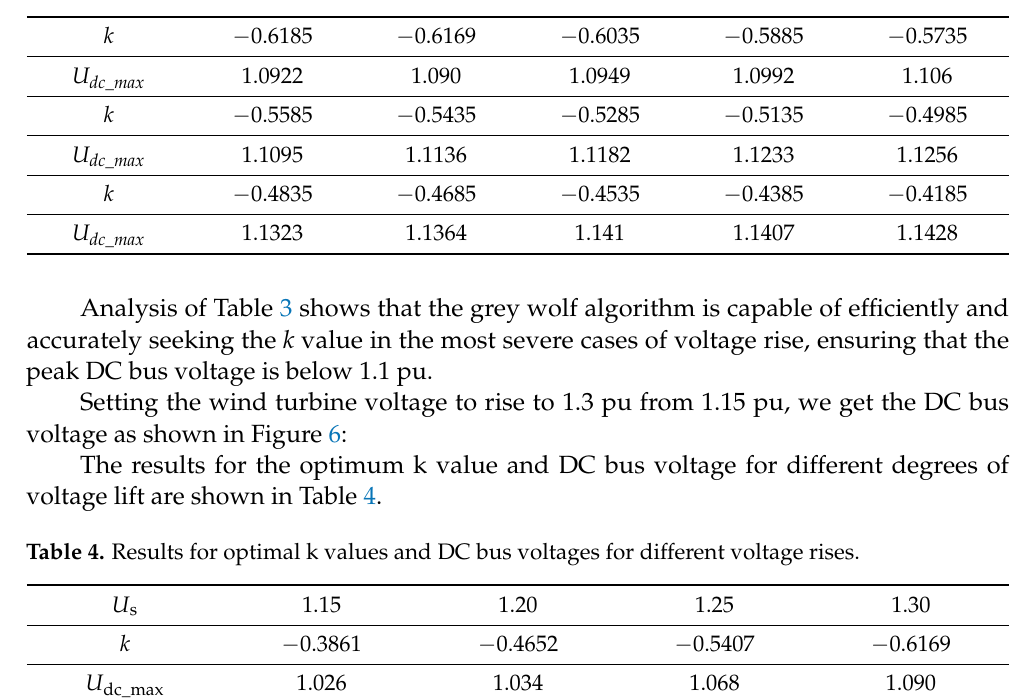
Table 3. DC bus voltage poles at different k values.